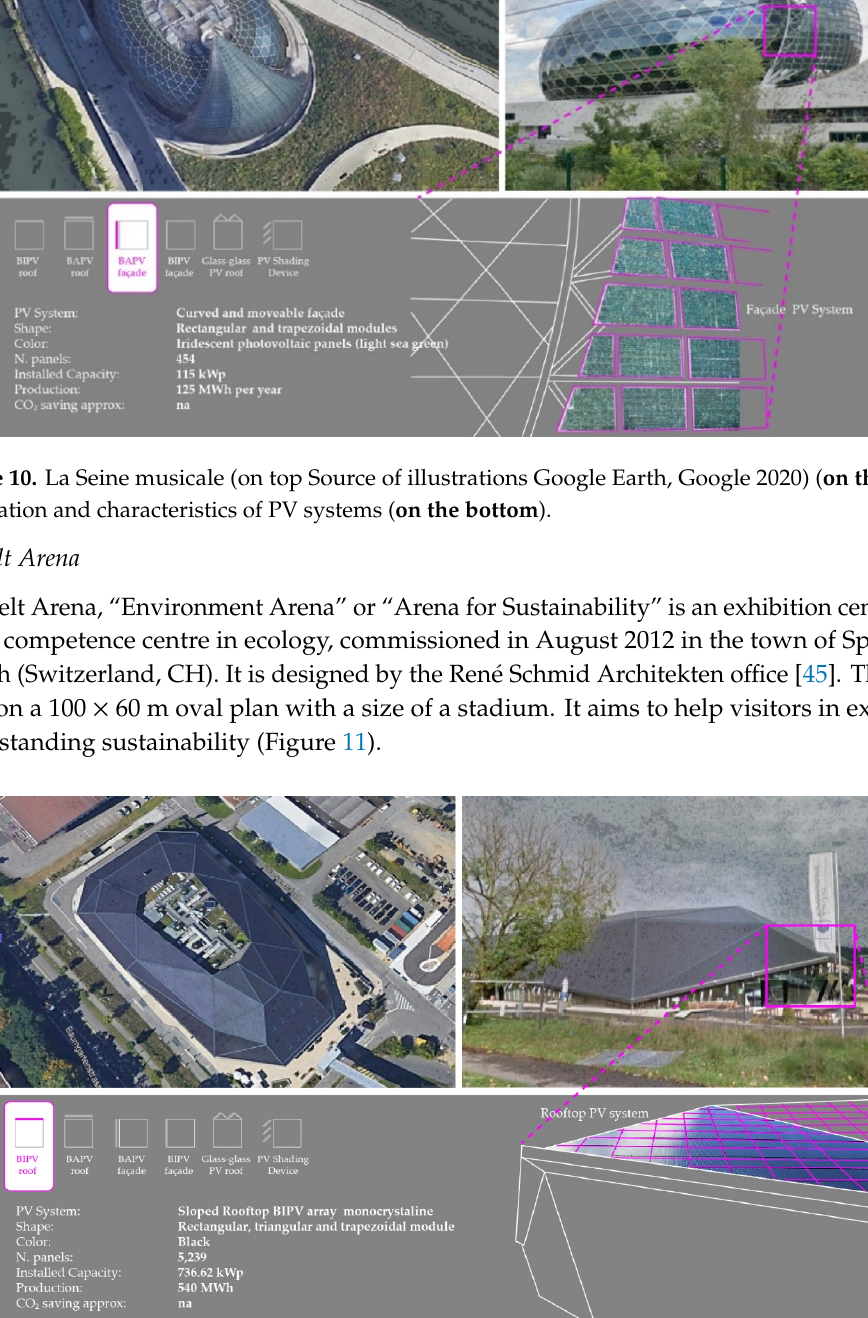
Figure 9. Paris Courthouse east façade (photography with permission of author Sergio Grazia) ( on the top ); Integration and characteristic of PV systems ( on the bottom ).